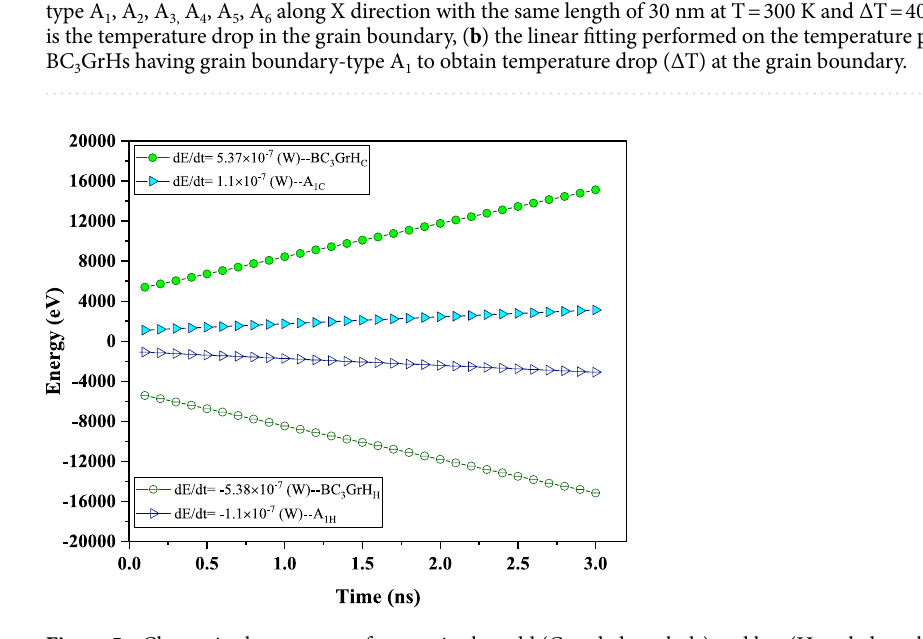
Figure 5. Change in the amounts of energy in the cold (C-coded symbols) and hot (H-coded symbols) slabs as a function of simulation time for BC 3 GrH having perfect grain boundary (hexagonal rings) and BC 3 GrH having grain boundary-type A 1 (5–7–6–6–s), with the same lengths and width of 30 nm and 10 nm, respectively, at T = 300 K and ΔT = 40 K. Filled symbols indicate effluent of H slab, while hollow symbols indicate heat entered into the C